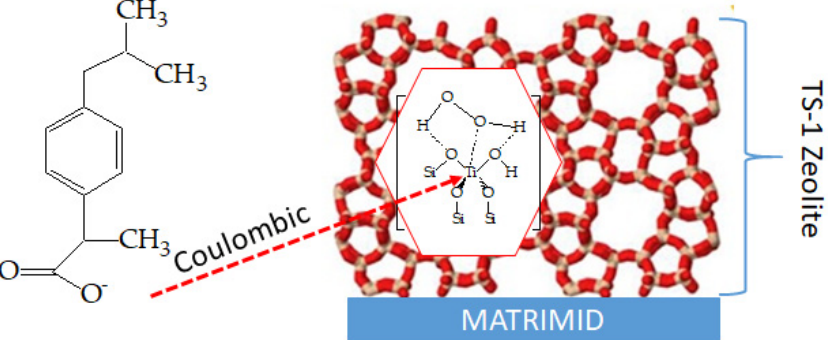
Scheme 2. Chemical interaction between TS-1 zeolite surface layer and